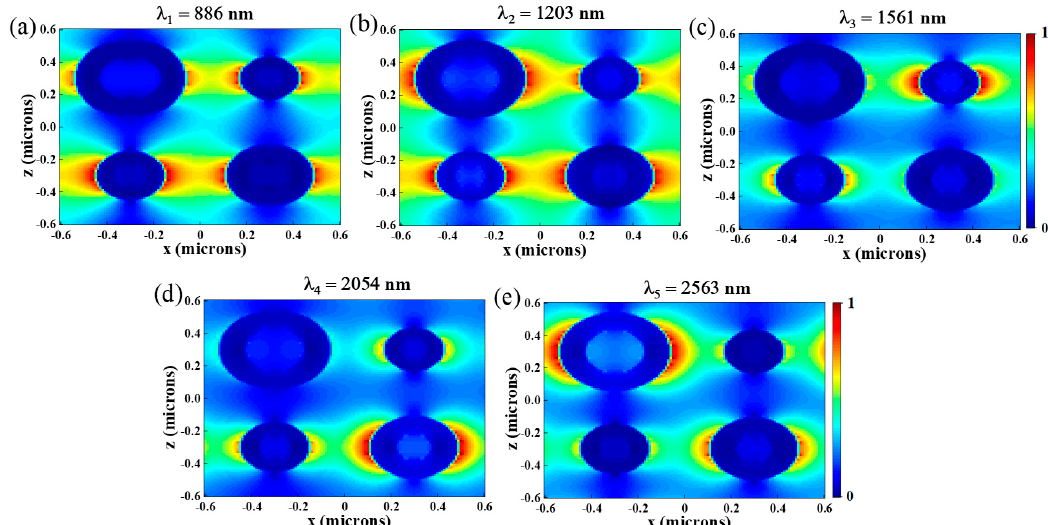
Figure 4. In the x – y plane, the electric field distribution of the absorber at ( a ) λ 1 = 886 nm, ( b ) λ 2 = 1204 nm, ( c ) λ 3 = 1561 nm, ( d ) λ 4 = 2054 nm, ( e ) λ 5 = 2563 nm.